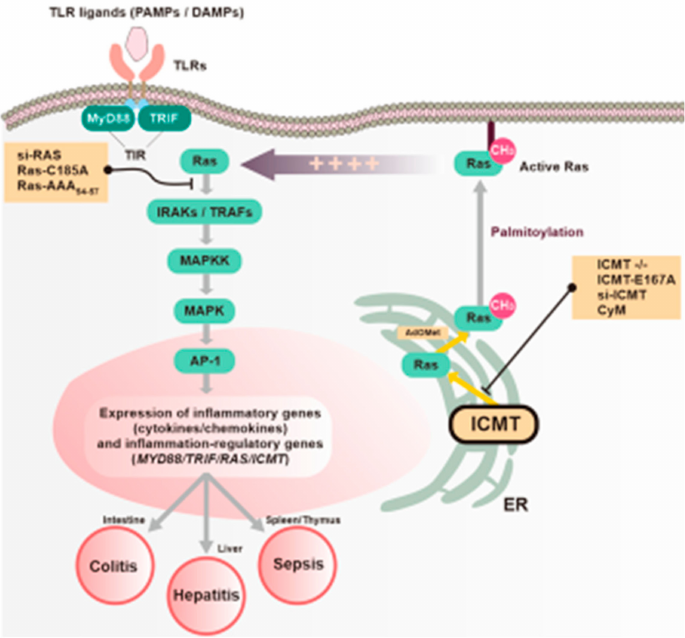
Figure 7. Proposed model of TIR domain-dependent regulation of Ras- and ICMT-mediated inflammatory responses in